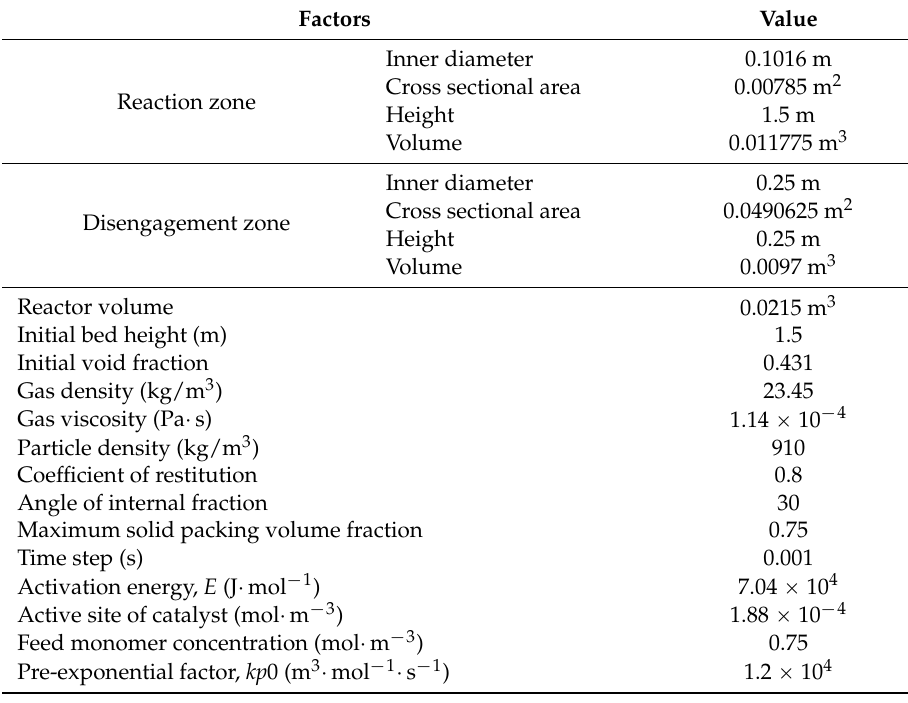
Table 4. Boundary conditions for simulation set